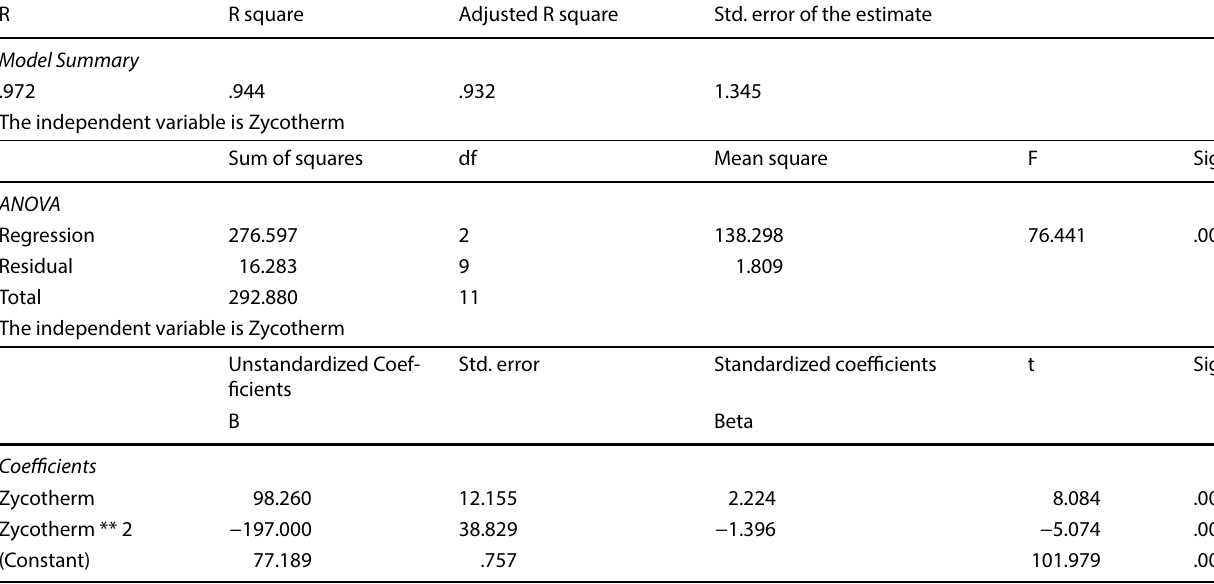
Table 6 Statistical analysis of TSR regression model—Magnesium Chloride